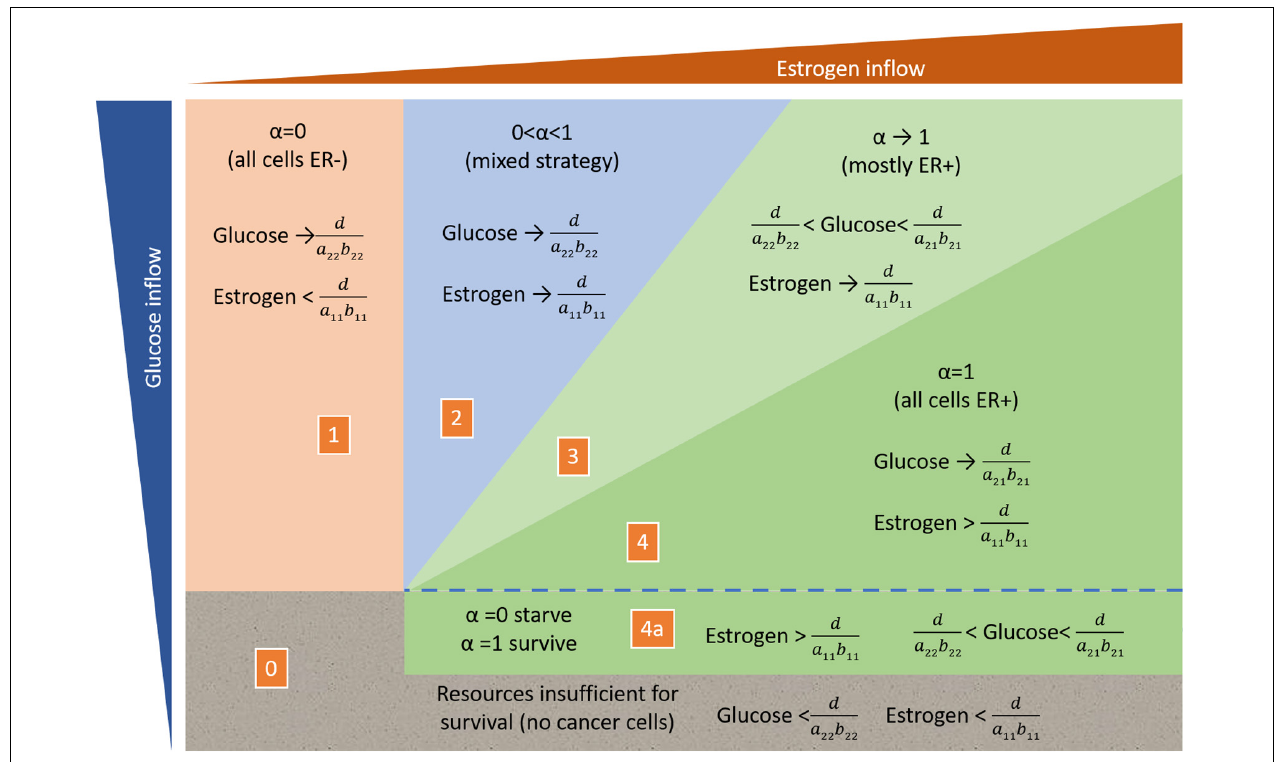
FIGURE 1 | Outcome of consumer resource dynamics as influenced by the resource supply point. The five regions show the qualitatively different outcomes described by System (Rosenzweig,